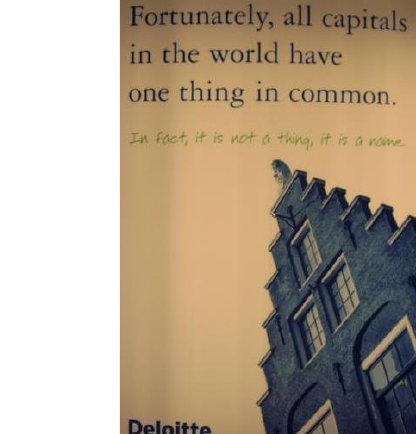
Figure 2. Website of Deloitte providing an option to select ‘location’ , giving addresses of offices. Source: https://www.deloitte.com/GlobalOfficeDirectory, accessed on 20 August 2022. Firms are selected based on rankings of leading service firms in key producer services sectors, a straightforward approach that has the advantage of facilitating future replica- tion of the data gathering. In recent data gatherings, and also the one underlying this pa- per, we focused on the leading firms in 5 sectors: 75 financial services firms, 25 manage- ment consultancy firms, 25 advertising firms, 25 law firms, and 25 accounting firms. The information on the location strategies of these firms was gathered from July – August 2020. Firms were selected based on sectoral rankings for 2019, which tended to be based upon